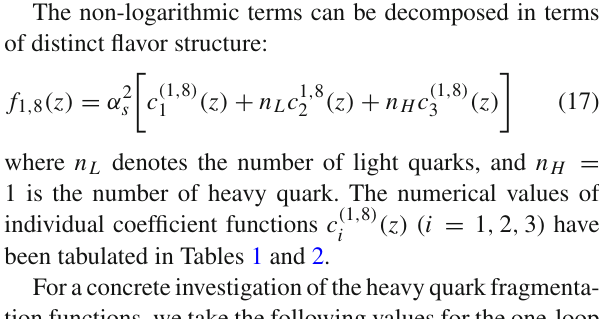
Fig. 2 The SDCs d 1 , 8 ( z ) associated with heavy quark fragmentation functions, accurate up to NLO in α s . The two figures in the left column correspond to d 1 , 8 ( z ) for charm quark fragmentation into charmonium, while the two figures in the right column correspond to those for bottom